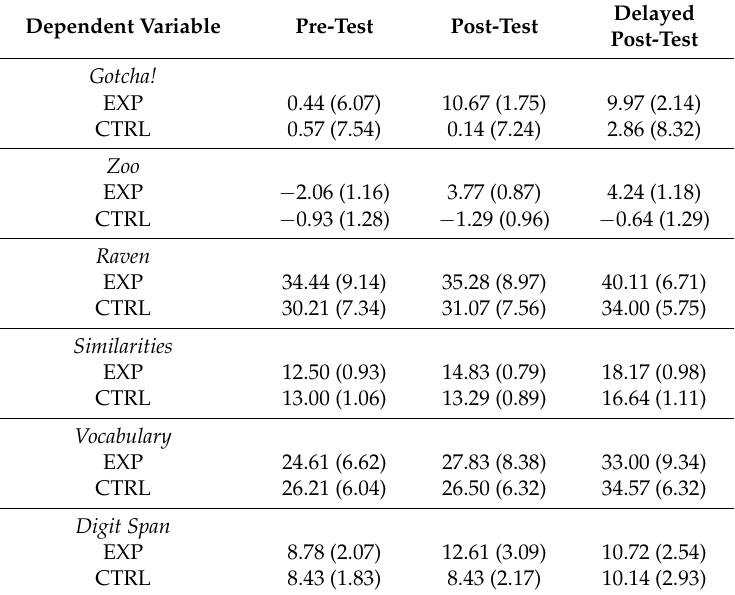
Table 4. The comparison of mean raw scores obtained by two groups (experimental and control) at three testing points (before training, immediately after training, 15 months after training). Standard deviations are presented in